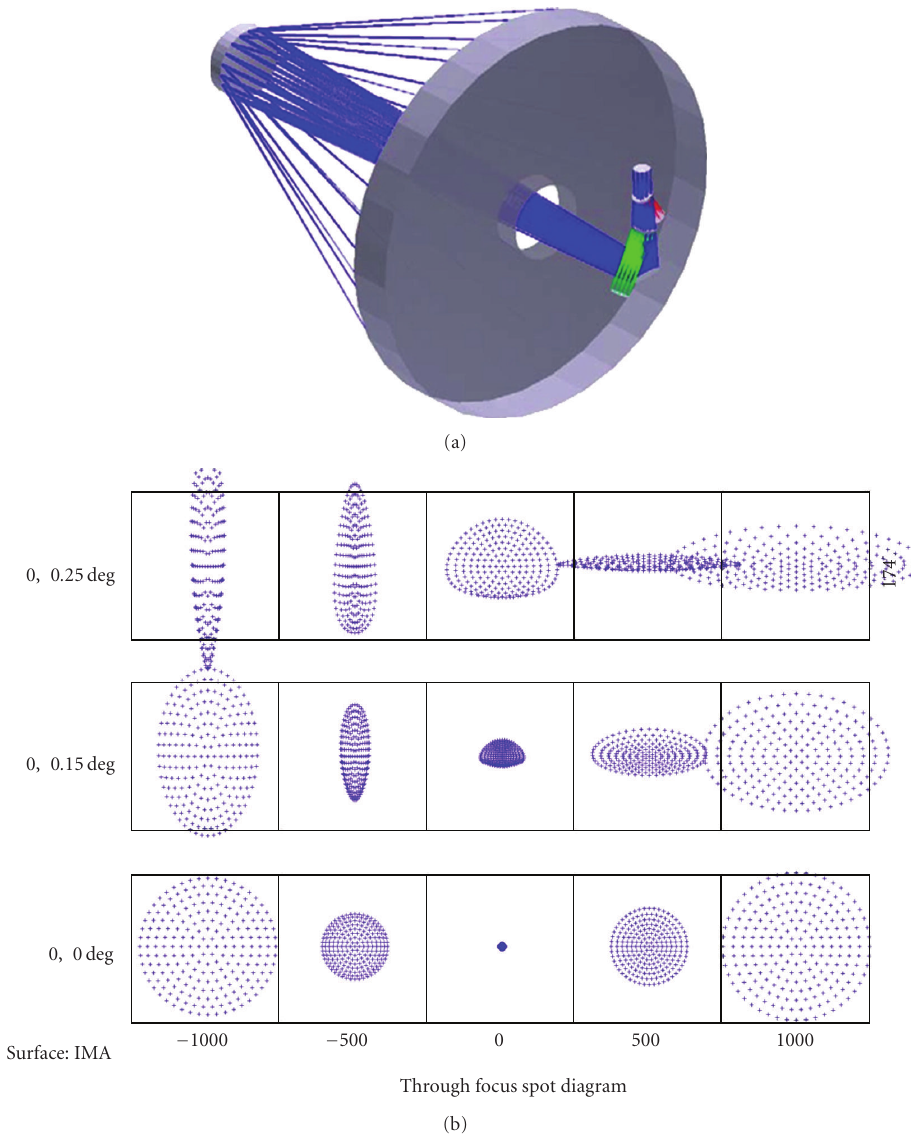
Figure 4: The optical scheme of the telescope and the relative spot